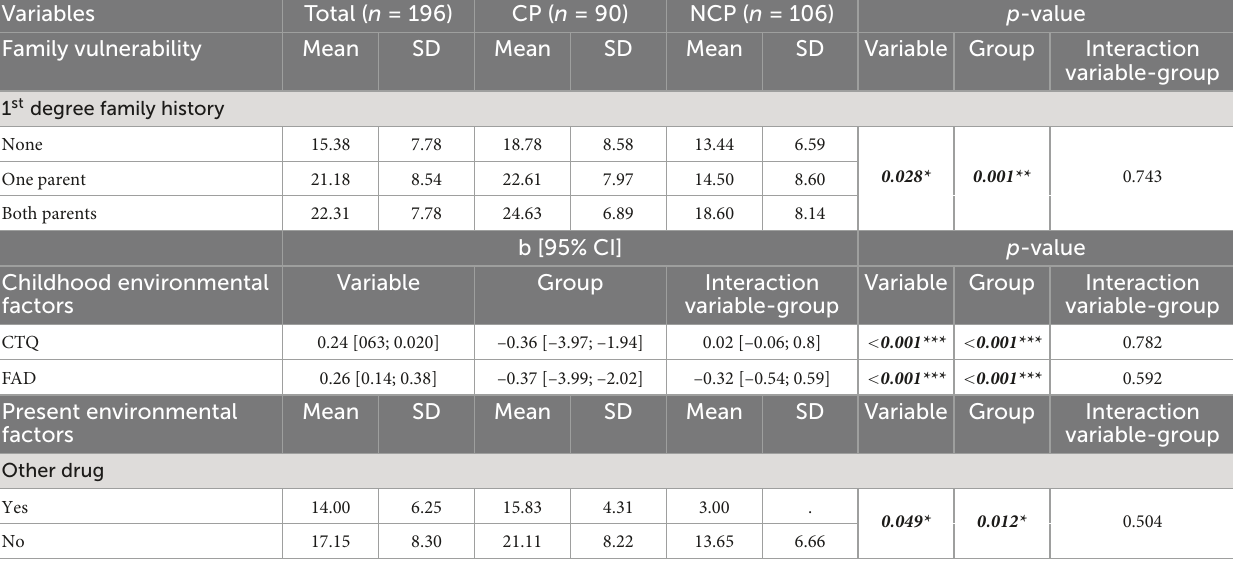
TABLE 4 Summary of the GHQ scores according to most significant